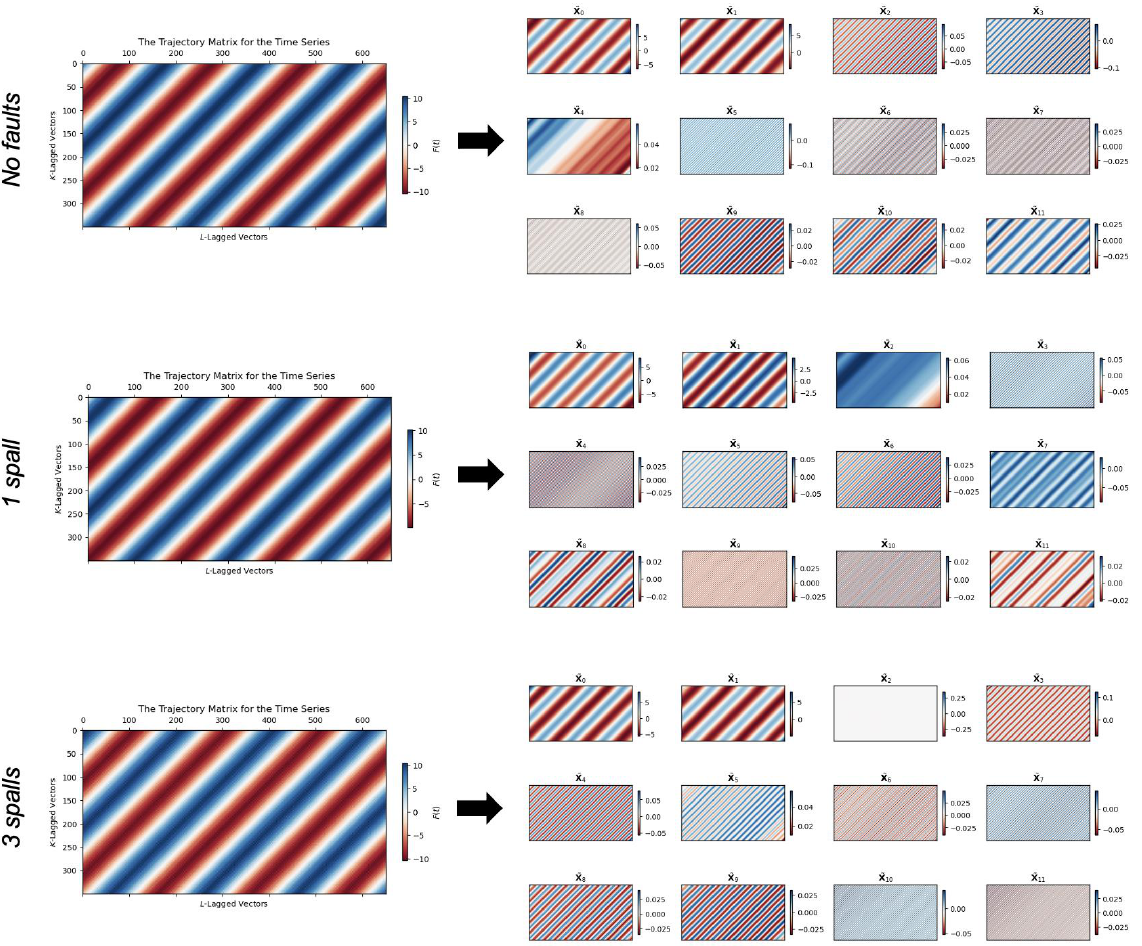
Figure 6. Construction of trajectory matrices for phase A and their decomposition into 12 components for the bearing without faults, the bearing with one spall and the bearing with three spalls.